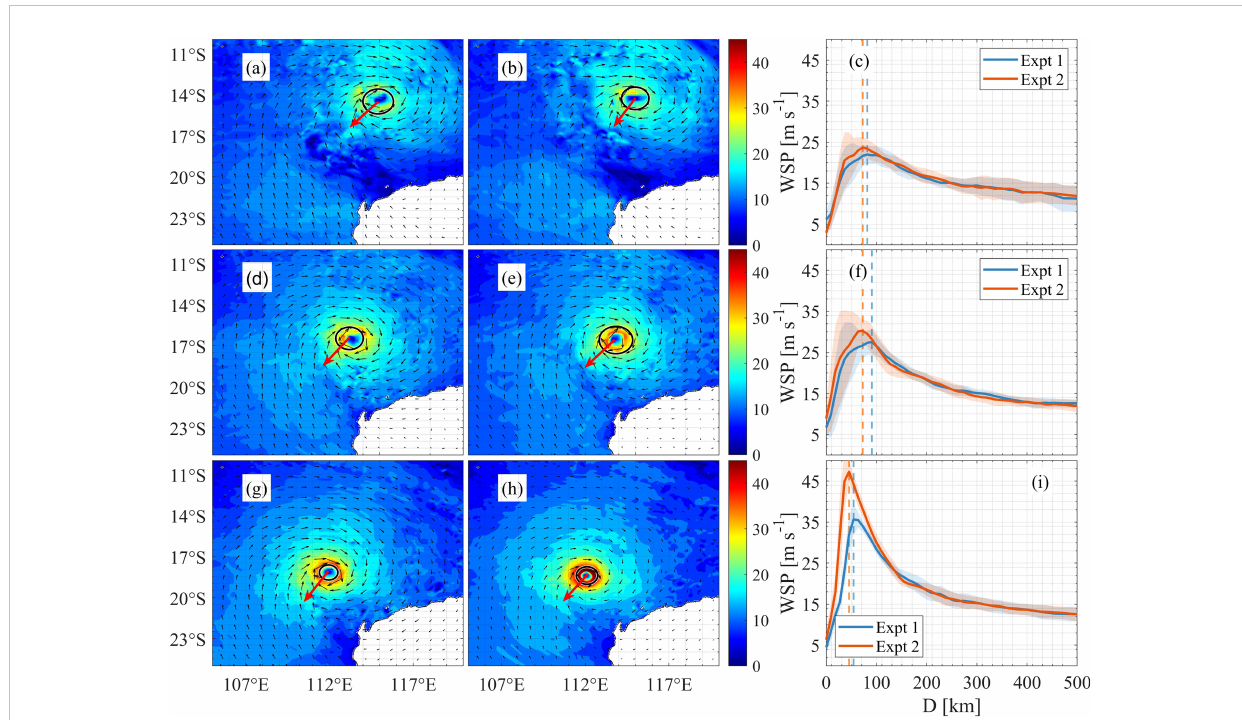
FIGURE 5 (A, D, G) are 10-m wind speed (U 10 ) without the spume scheme on 10 – 12 January 2013. (B, E, H) are the same as (A, D, G) but with the spume scheme. (C, F, I) represent the azimuthal averages of U 10 . The direction in which TC Narelle is moving forward at different times is demonstrated by the red arrows. The vectors are the directions of the local winds. The azimuthal averages of U 10 are shown by solid lines. The standard deviations of U 10 in all radial directions are represented by shadows. The radius of maximum wind is represented by solid circles and dashed lines in spatial distributions and azimuthal averages,